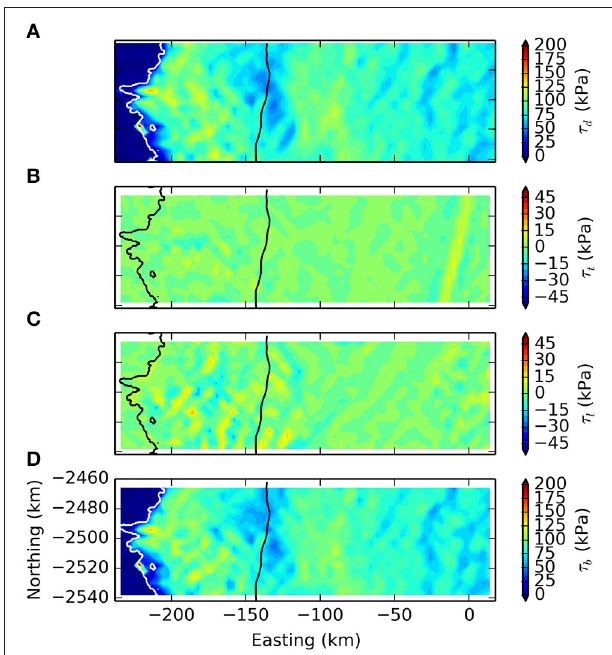
FIGURE 7 | Force balance calculation results across the study domain showing driving stress (A), lateral drag (B), longitudinal stress gradient (C), and the basal drag residual (D). Black line shows the approximate long term ELA (1553m elevation) for reference. Note the difference in scale between resistive terms (B,C) , and driving stress (A) and basal shear (D)